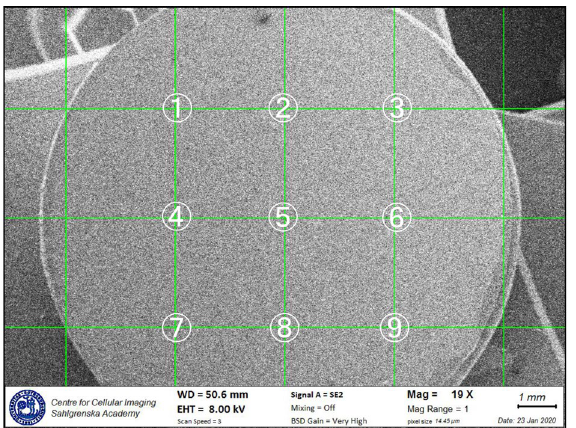
Figure 1. SEM image of a titanium disc with overlaid grid. Higher magnification images were obtained at the prespecified nine